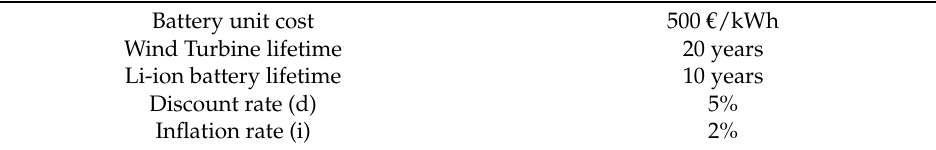
Table 5. Economic parameters.